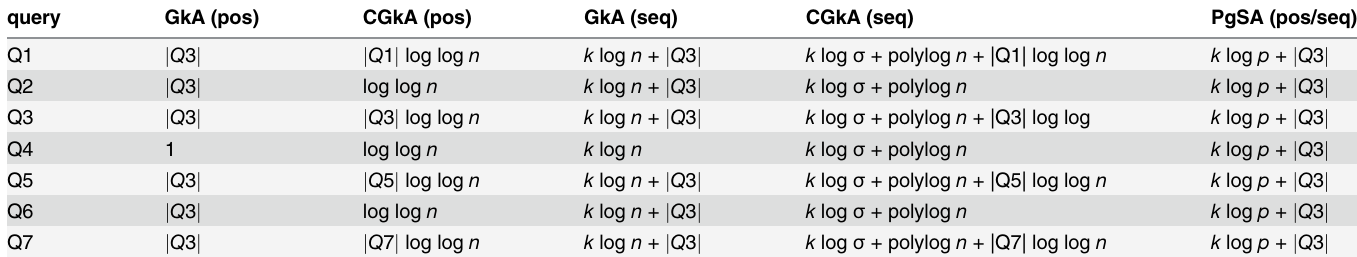
Table 1. Worst-case time complexities. To save space, the O (.) symbols around each formula were omitted. Note that n = q ( m − k +1). The time complexi- ties for PgSA are given for the fixed- k mode with SA sparsity set to 1. In the variable- k mode or when SA sparsity larger than 1 is used, the number of visited SA PG locations should be added to the PgSA complexities.